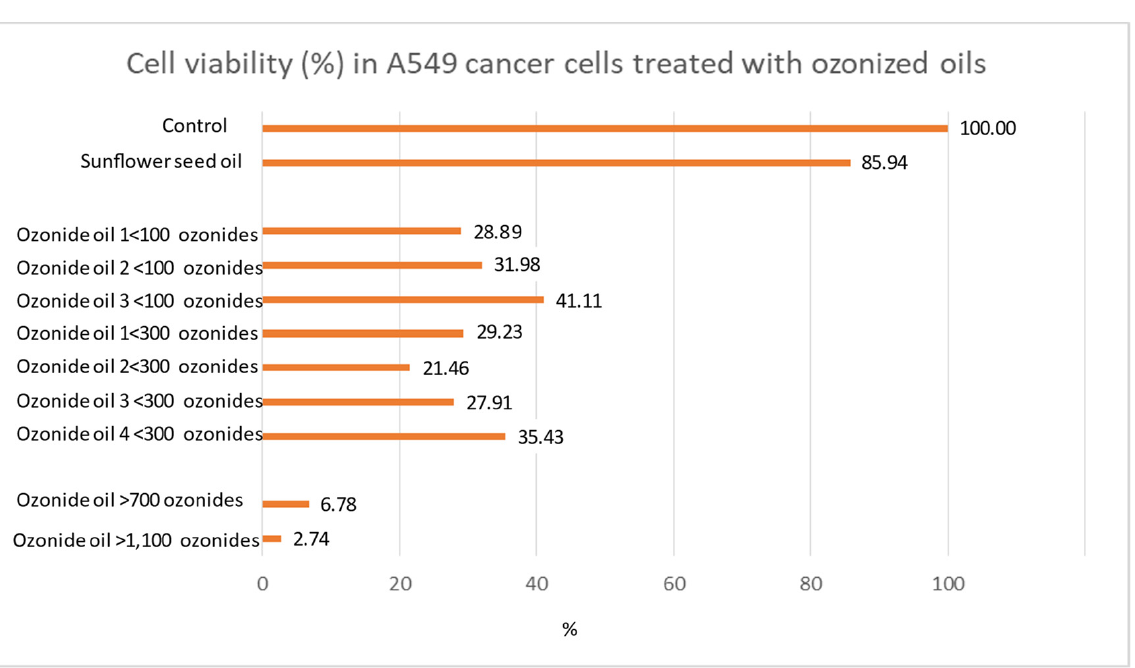
Figure 1. Comparative evaluation of ozonized oil effect on cancer cell viability (MTT test). Only ozonized oils having an ozonide content >700 decrease cancer cell viability below 10% in 24 h.